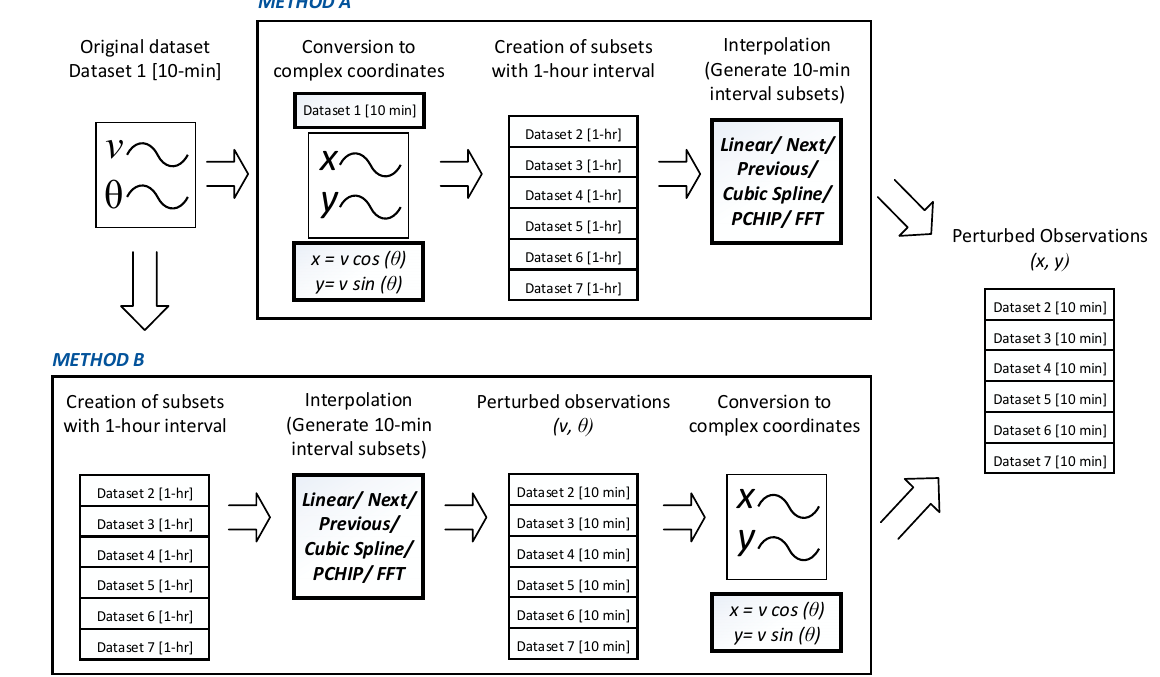
Figure 3. The two methods that can be used for pre-processing the dataset and generating the perturbed observations from the original dataset. Method A: the original dataset is converted to its complex format first and then the interpolation technique will be implemented. Method B: the interpolation technique is implemented first, and then the interpolated data sets are converted to the complex format.